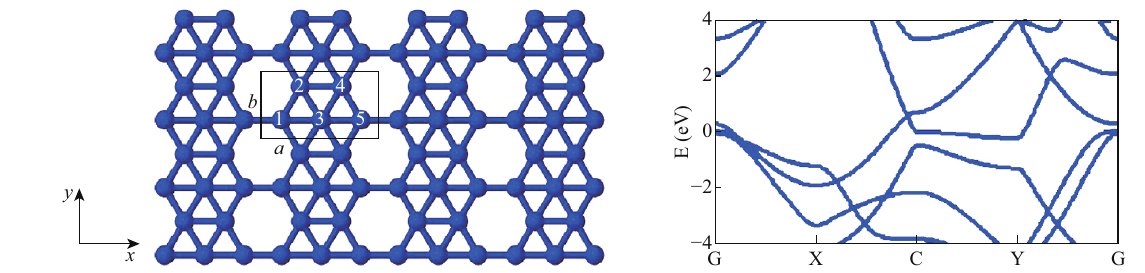
Fig. 1 Scheme of the freestanding b 12 -borophene sheet. The unit cell is shown by the rectangle with a and b vectors (left panel). The band structure of the freestanding b 12 -borophene sheet (right panel)